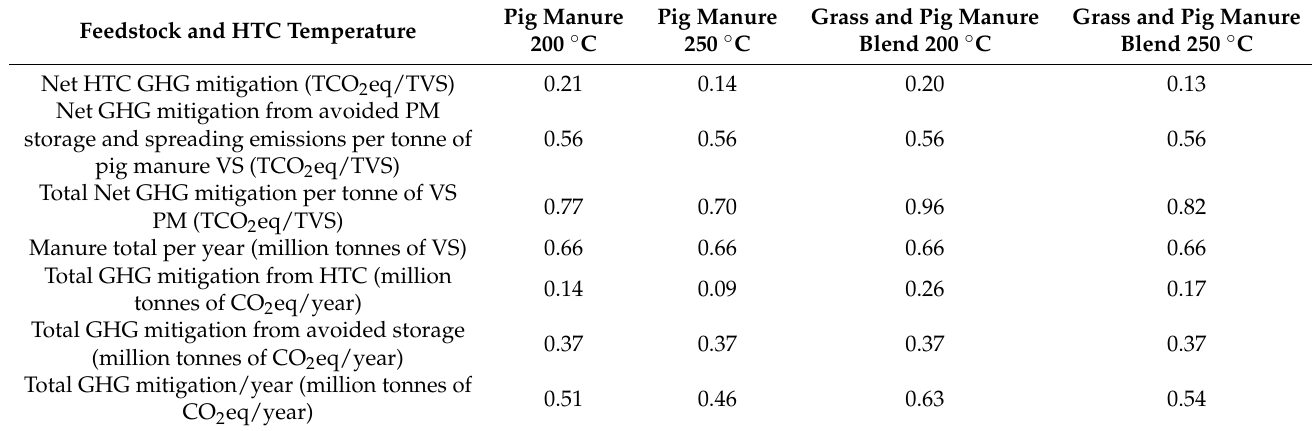
Table 2. UK GHG mitigation from HTC of PM and PM-grass blend.